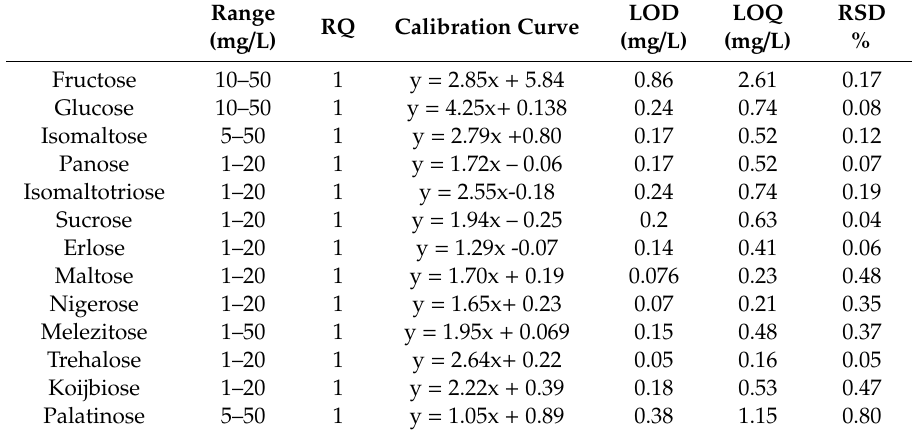
Table 5. Evaluation of linearity range, correlation factor, calibration curves, LOD, LOQ, and precision (expressed as relative standard deviation, RSD%) of the analyzed standards by HPAEC–PAD.